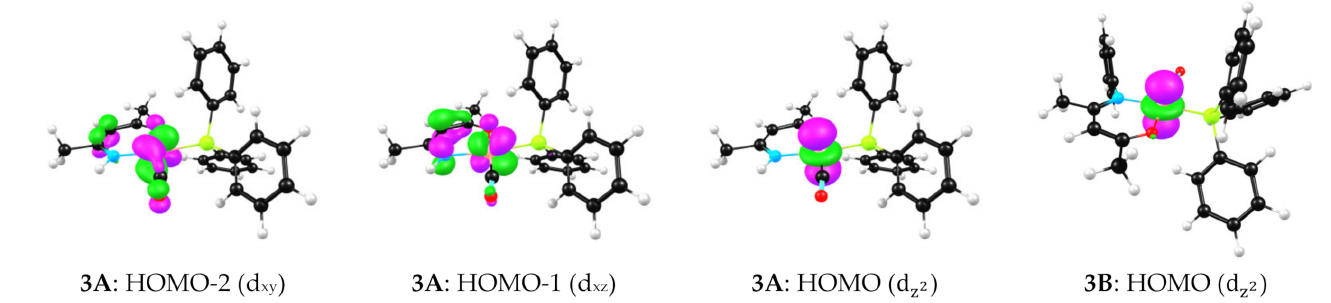
Figure 2. Selected Kohn-Sham frontier orbitals of the DFT PW91/TZP optimized geometry of the main isomers (O- trans -CO) of [Rh(CH 3 COCHCNHCH 3 )(CO)(PPh 3 )] 3A and [Rh(CH 3 COCHCNPhCH 3 ) (CO)(PPh 3 )] 3B